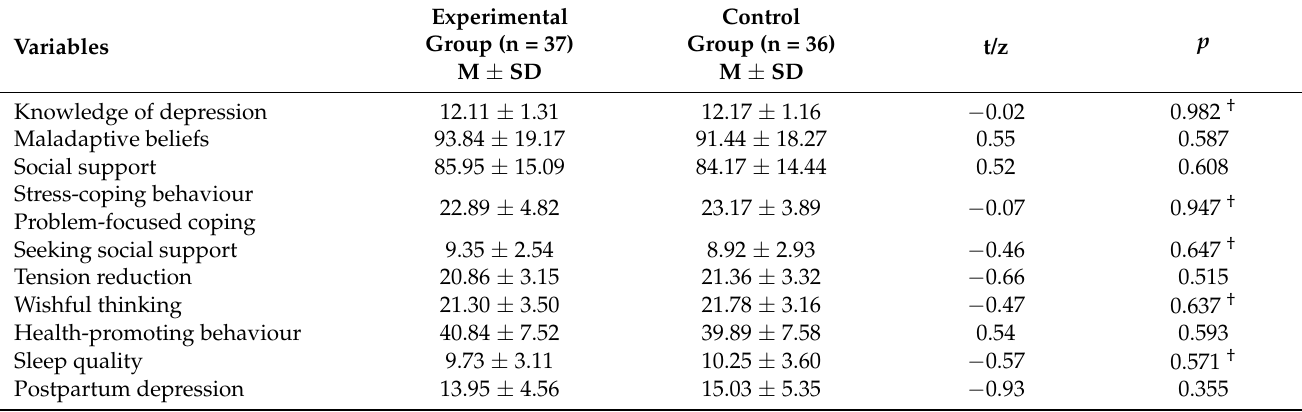
Table 2. Homogeneity Test of Dependent Variables between Groups (N =